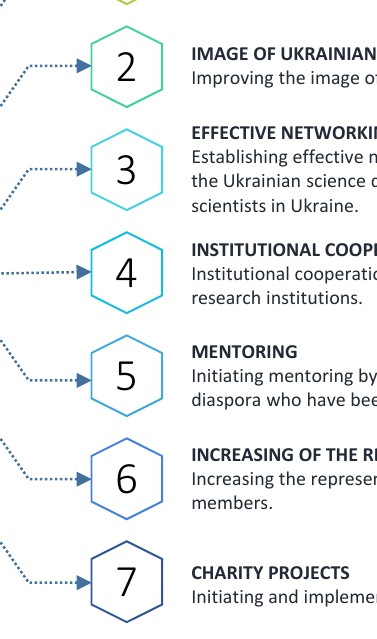
Figure 1. Opportunities offered by the “Ukrainian Science Diaspora”